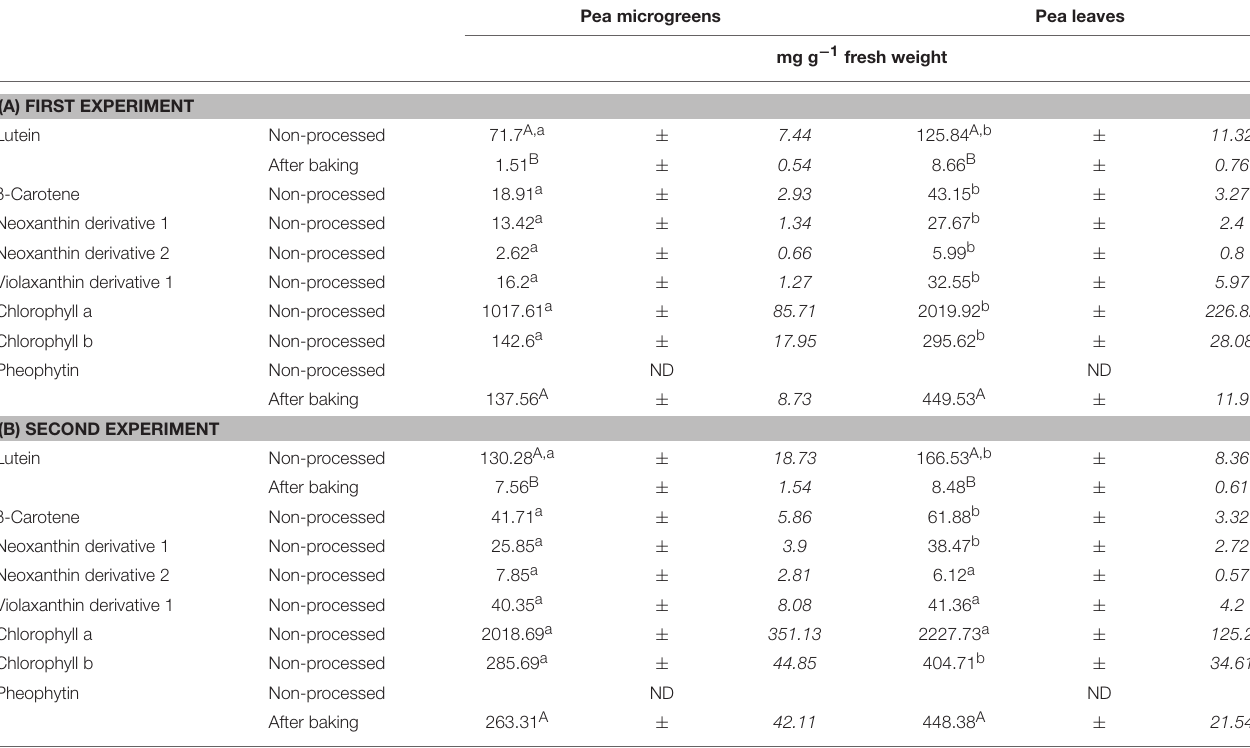
TABLE 3 | Average carotenoid and chlorophyll derivative concentration in Pea microgreens (7 d) and leaves (14 d): Non-processed and in the pea-enriched